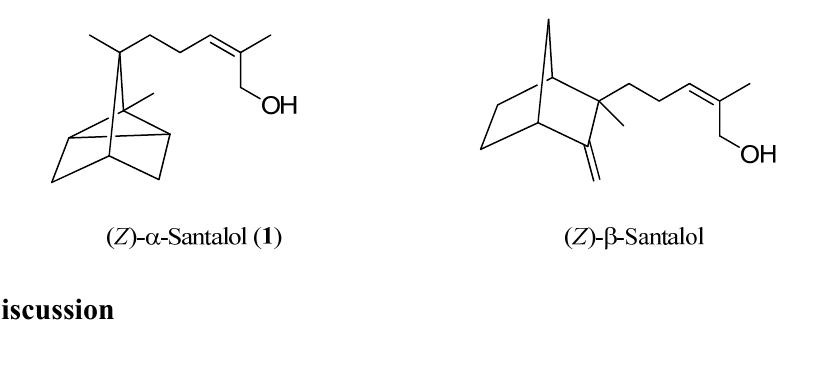
Figure 1. Main constituents of